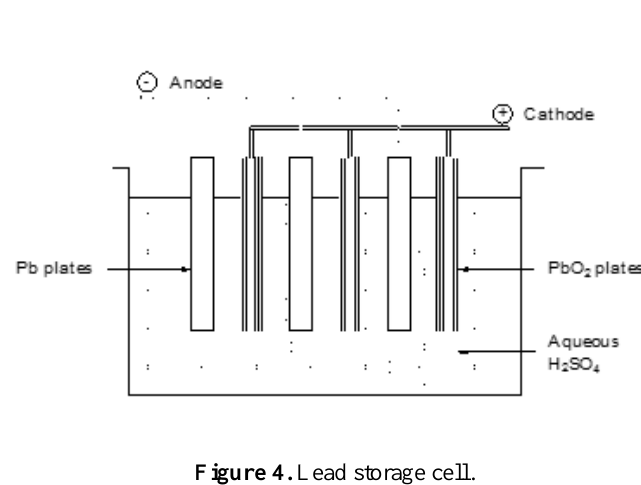
Figure 4. Lead storage